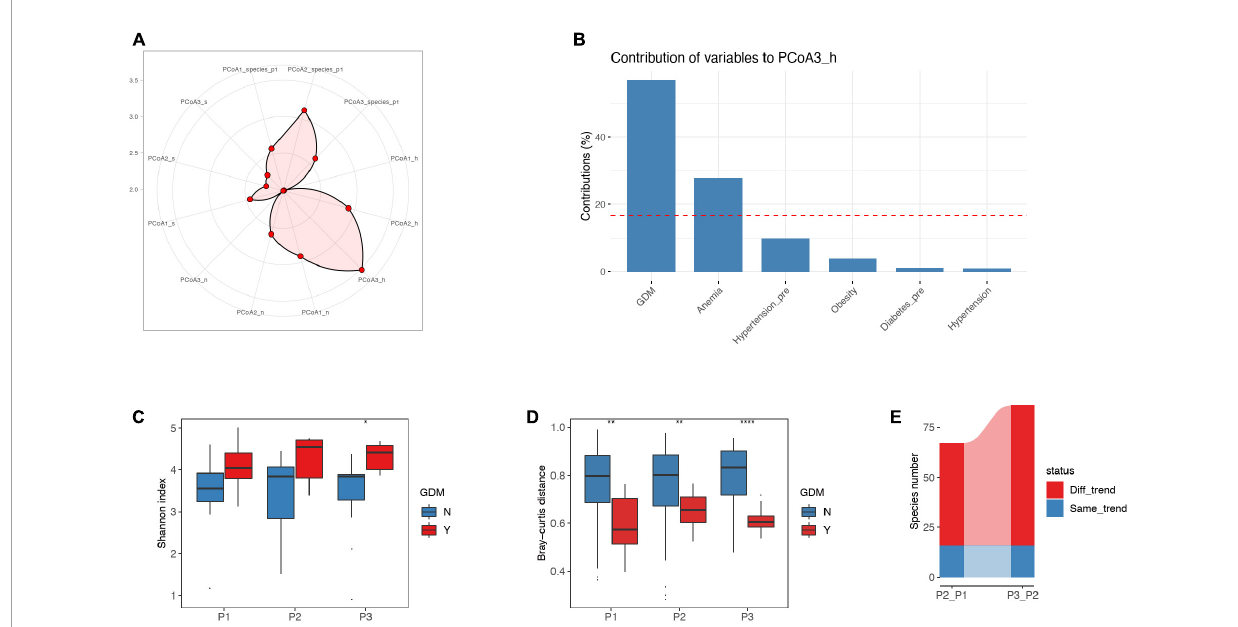
FIGURE3 Factors impacting GM dynamics in accordance with trimester progression. (A) Permutational multivariate analysis of variance (PERMANOVA) was adopted to assess the effects of several indices on GM dynamics: the variable was more significant when the point was located nearer the outer circle. PCoA1_species_p1, PCoA2_species_p1, and PCoA3_species_p1 represent the first, second, and third principal components for baseline species-level GM structures, respectively. PCoA1_h, PCoA2_h, and PCoA3_h represent the first, second, and third principal components for health status, including GDM, hypertension, anemia, obesity, pre-pregnancy diabetes and hypertension. PCoA1_n, PCoA2_n, and PCoA3_n represent the first, second, and third principal components for daily nutrient intake at each trimester, including micro- and macro-nutrients. PCoA1_s, PCoA2_s, and PCoA3_s represent the first, second, and third principal components for socioeconomic status, including income and education. Analytic result exhibited a notable association between PCoA3_h and GM dynamics. (B) Contribution of factors in PCoA3_h, suggesting that GDM contributed ≥ 50% to the PCoA3_h. (C) The differences in Shannon index between GDM and non-GDM women at the P1, P2, and P3 timepoints. Women with GDM manifested higher microbial diversity than non-GDM women, and the difference was significant at the P3 timepoints. (D) Inter-individual Bray-Curtis distance with respect to microbial samples for women with GDM was significantly lower than that for non-GDM women, suggesting a greater similarity of microbial samples in the GDM group. (E) For the P2_P1 GM changes, 16 species possessed similar changing trends (increase or decrease) and 51 species showed different changing trends between GDM and non-GDM women. For the P3_P2 GM changes, 16 species had a similarly changing trend and 70 species had different changing trends between GDM and non-GDM women. P1, P2, and P3 represent the first, second, and third trimesters, respectively. The Wilcoxon rank-sum test was applied to analyze the significance of inter-group differences, and the P -value was adjusted by the Benjamini–Hochberg method. *, **, **** represent adjusted P < 0.05, P < 0.01 and P < 0.0001,